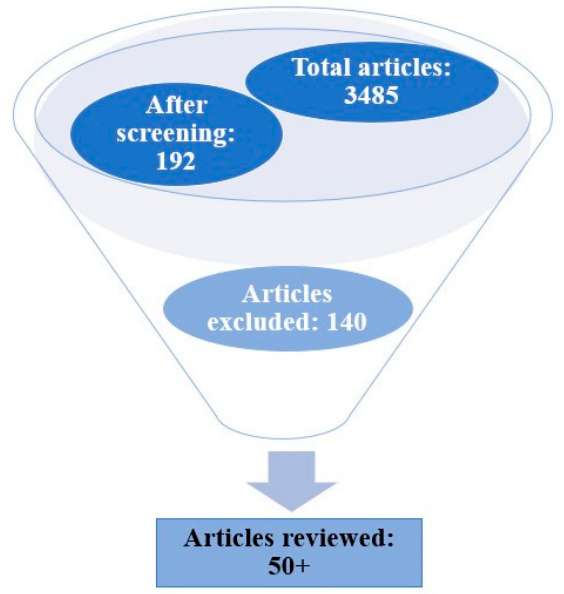
Figure 3. Search strategy flowchart adopted for the review .